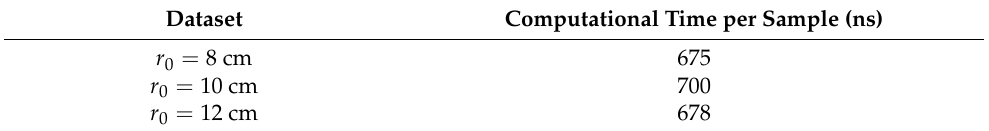
Table 6. Means of the computational time needed by the FCN model per sample for each test dataset. Dataset